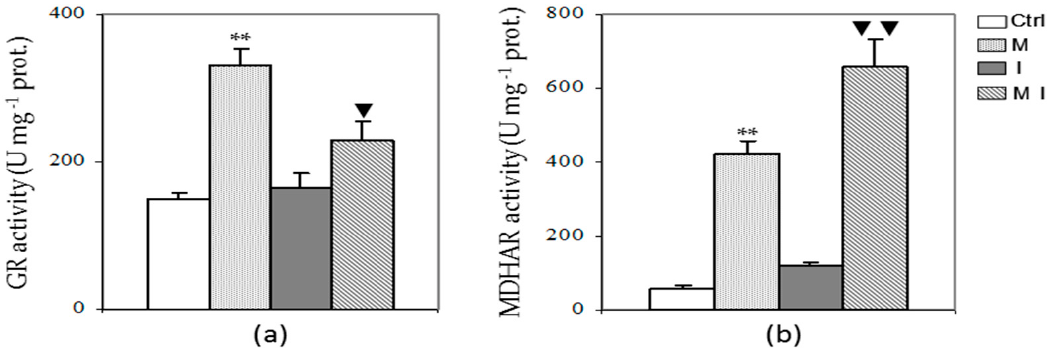
Figure 4. Enzymatic activity of glutathione reductase (GR) ( a ) and monodehydroascorbate reductase (MDHAR) ( b ) in the cytosolic fraction of artichoke control plants (Ctrl), mycorrhizal plants (M), plants inoculated with Verticillium dahliae (I), and in mycorrhizal plants inoculated with V. dahliae (MI). For GR activity, 1 U = 1 nmol of NADPH oxidized min − 1 ; for MDHAR activity, 1 U = 1 nmol of NADH oxidized min − 1 ; prot. = proteins. The results are given as the mean values of at least five experiments ± SD; * * indicates values significantly different from the control (Ctrl) by the Student’s t test with p < 0.01; ▼ and ▼▼ indicate values significantly different from the artichoke inoculated with V. dahliae (I) by the Student’s t test with p < 0.05 and 0.01, respectively.